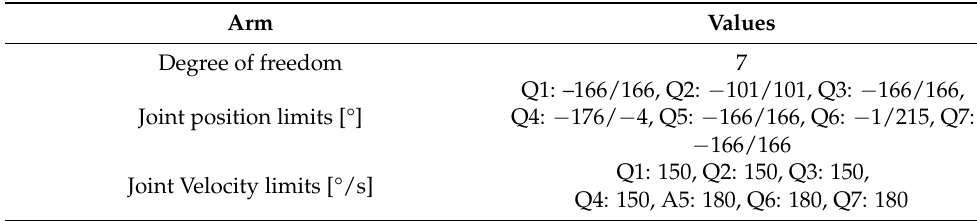
Table 1. Parameters for each of the joints.